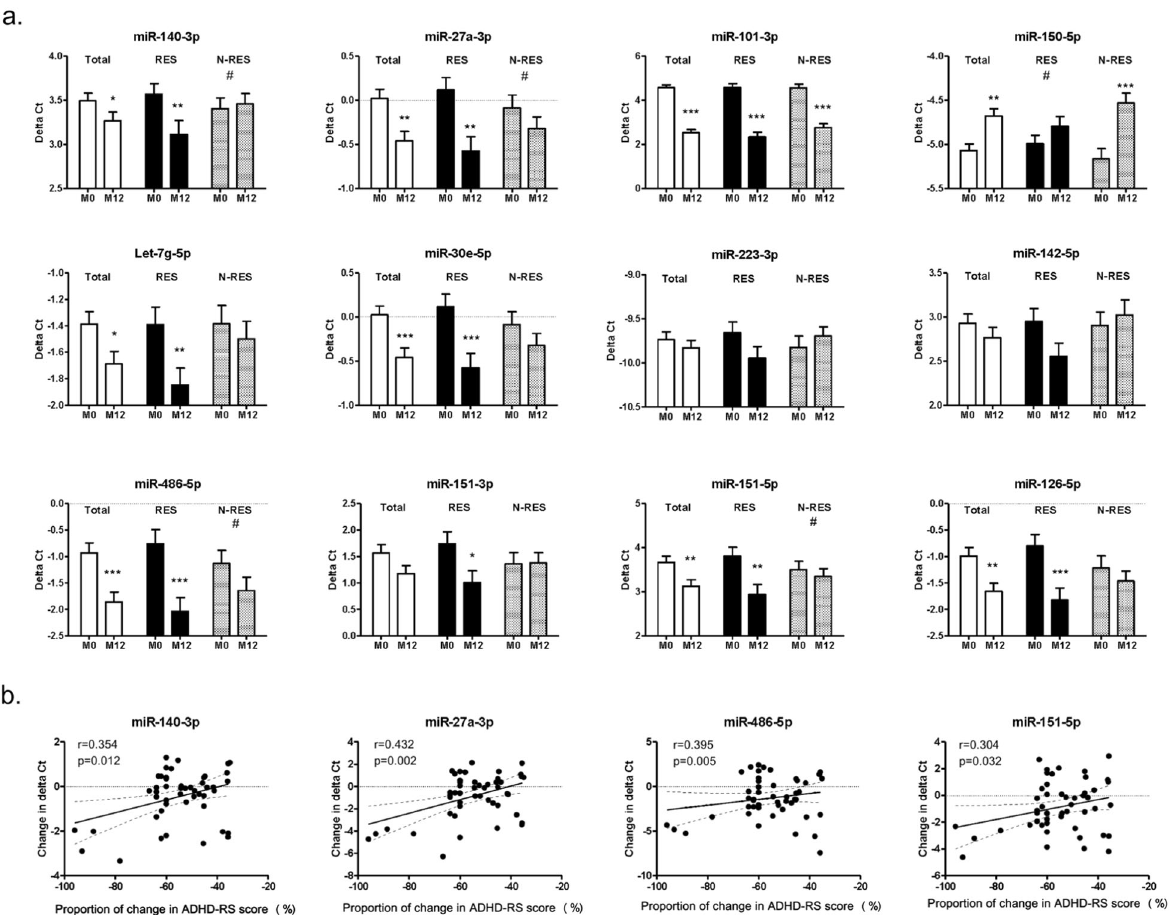
Fig. 2 The miRNA expression pro fi le in ADHD patients after 12-month methylphenidate treatment and their relationships with the proportion of change in total ADHD-RS scores. a The miRNA expression pro fi le in total ADHD patients ( n = 92), responders (RES, n = 50) and non-responders (N-RES, n = 42) after 12-month methylphenidate treatment. The p values of Δ Ct values comparisons between baseline (M0) and the endpoint (M12) were derived with a paired t -test. *, **, *** and **** denote p value < 0.05, p value < 0.01, p value < 0.001, and p value < 0.0001, respectively. # denotes signi fi cant interaction effects of treatment response and time on Δ Ct values (using repeated measure of ANOVA). b The relationships between changes in miRNAs and the proportion of change in total ADHD-RS scores among the responders during the 12-month follow-up. The changes in ADHD-RS scores showed a signi fi cantly positive correlation between changes in Δ Ct values of miR-140-3p ( r = 0.354, p = 0.012), miR-27a-3p ( r = 0.432, p = 0.002), miR-486-5p ( r = 0.395, p = 0.005), and miR-151-5p ( r = 0.304, p = 0.032). The dashed lines indicate the 95% con fi dence interval of